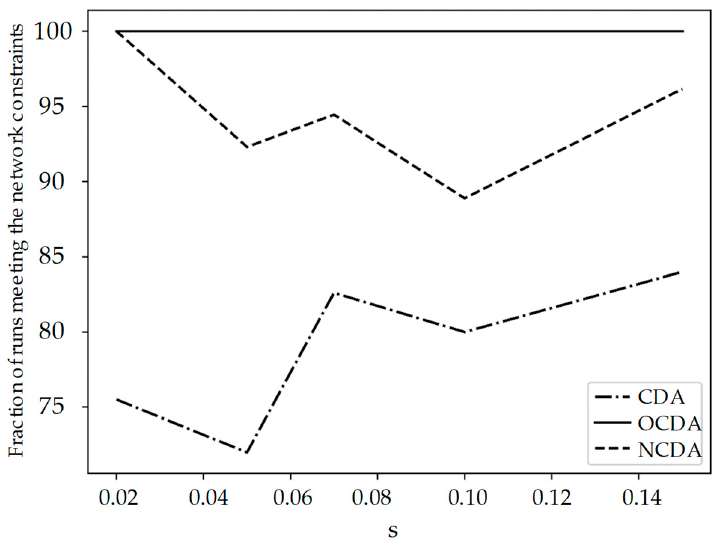
Figure 6. The ratio of market solutions that meet technical constraints for CDA, NCDA and OCDA, for di ff erent system variabilities.